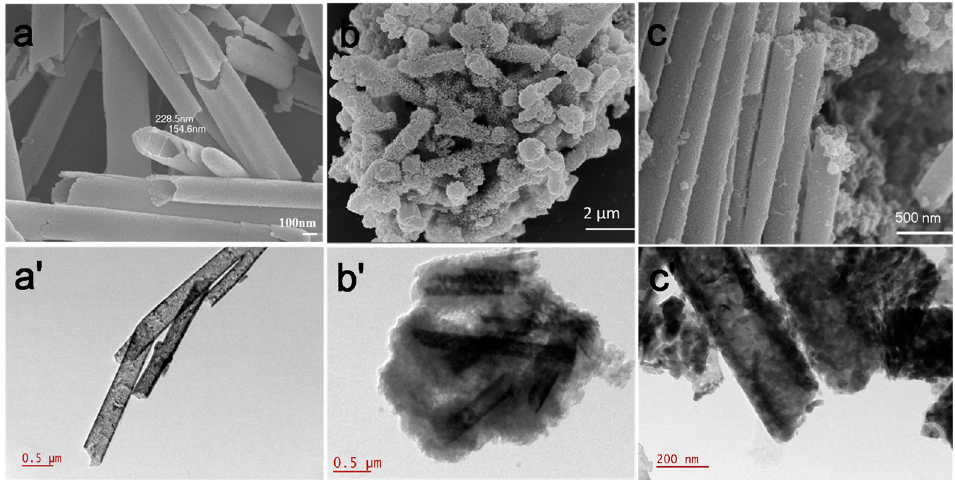
Figure 2. SEM and TEM images of the prepared PANI@ α -NTs; ( a , a’ ) α -NT, ( b ,b’) PANI@ α -NT-a, ( c , c’ ) PANI@ α -NT-b.